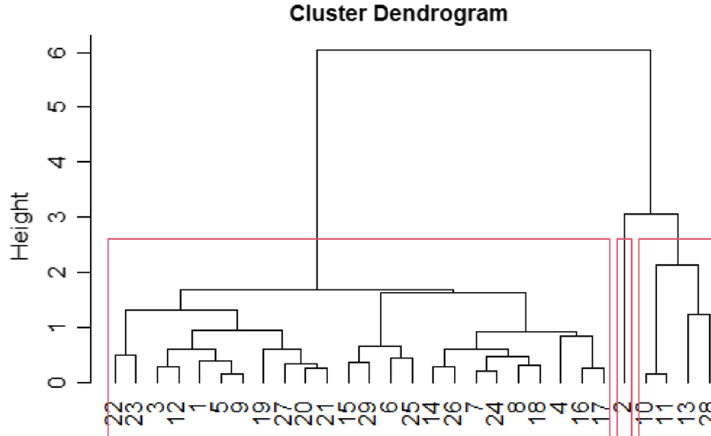
Fig. 10 Cluster dendrogram with time series correlation in stage 2